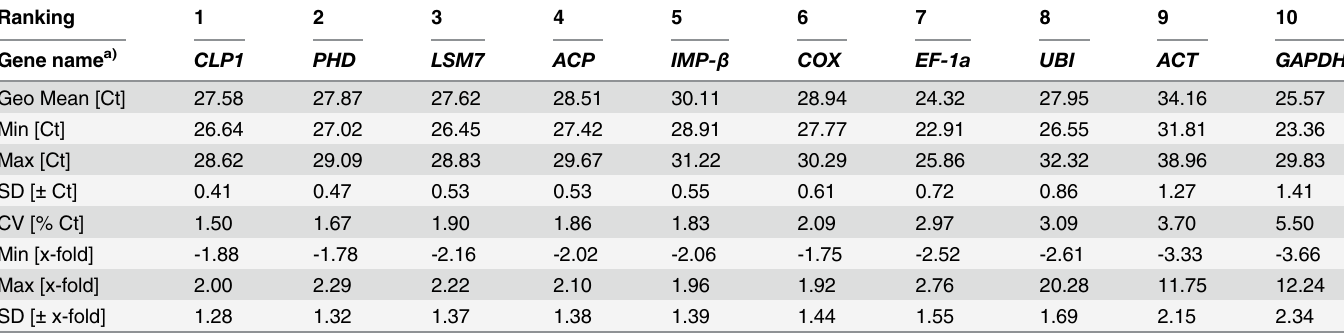
Table 2. Descriptive statistics of six newly identified and four classical tomato reference genes based on their crossing point values in all samples combined (n = 48) as calculated by BestKeeper.